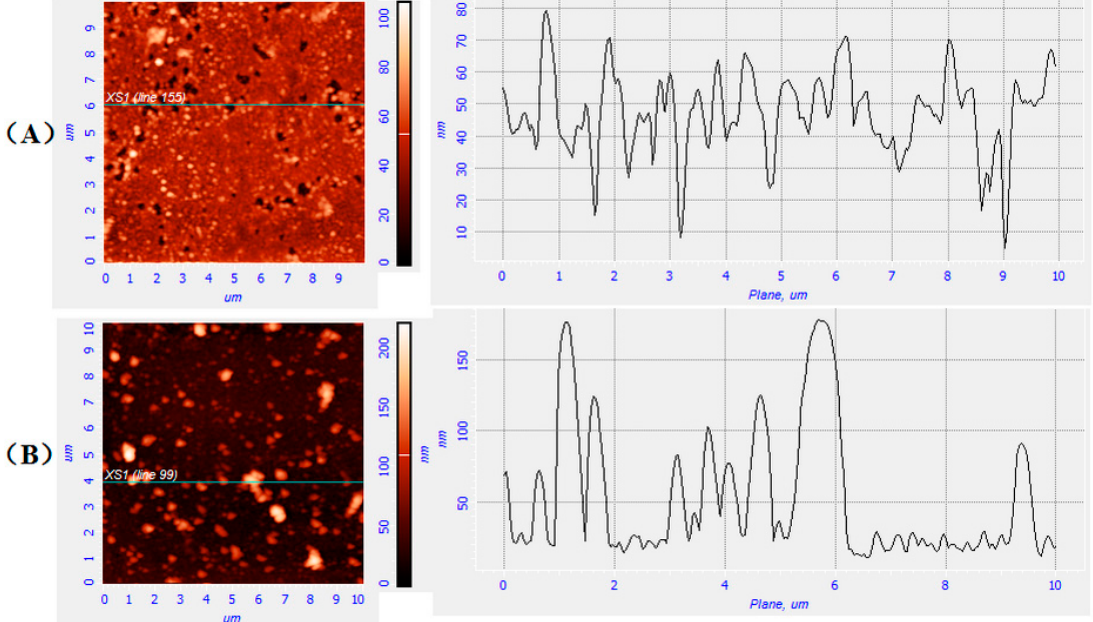
Figure 8. AFM images for glass surfaces with particle deposition of PNHT copolymers in UHQ water at 20 °C ( A ) and 37 °C ( B ).